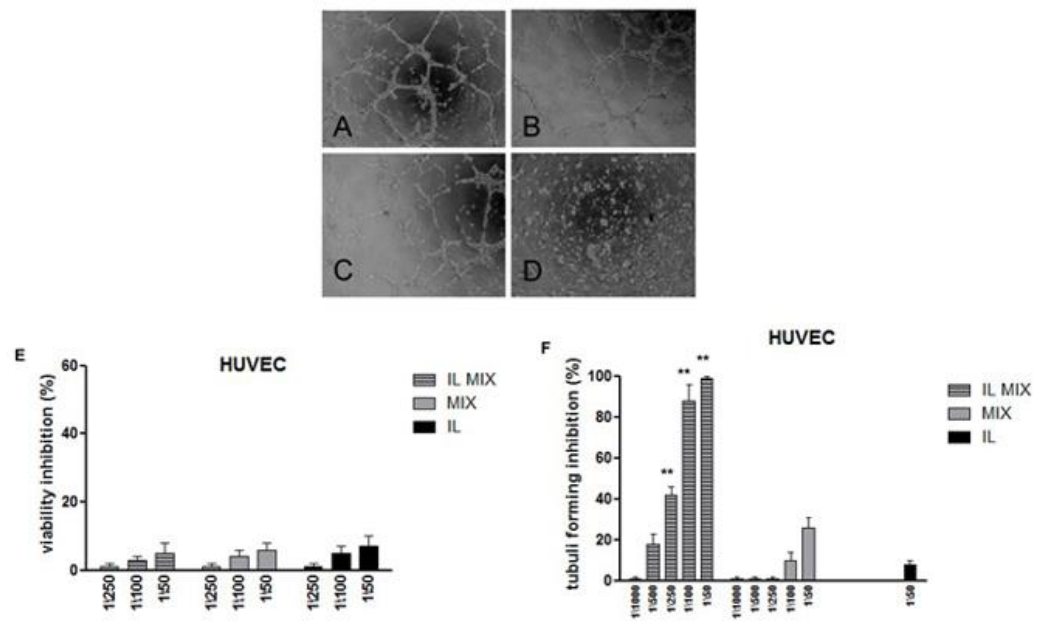
Figure 5. Tube formation assay; ( A ) Ctrl; ( B ) IL 1:50; ( C ) MIX 1:50; ( D ) IL MIX 1:50; ( E ) 6 h viability inhibition on HUVEC; ( F ) quantification of tube forming assay (6 h); ** IL MIX vs. MIX p < 0.01. IL: Intralipid ® ; MIX: combination of drugs; IL MIX: MIX co-loaded in IL.